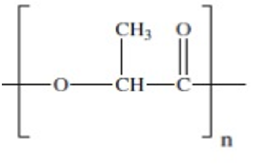
Figure 1. Chemical structure of